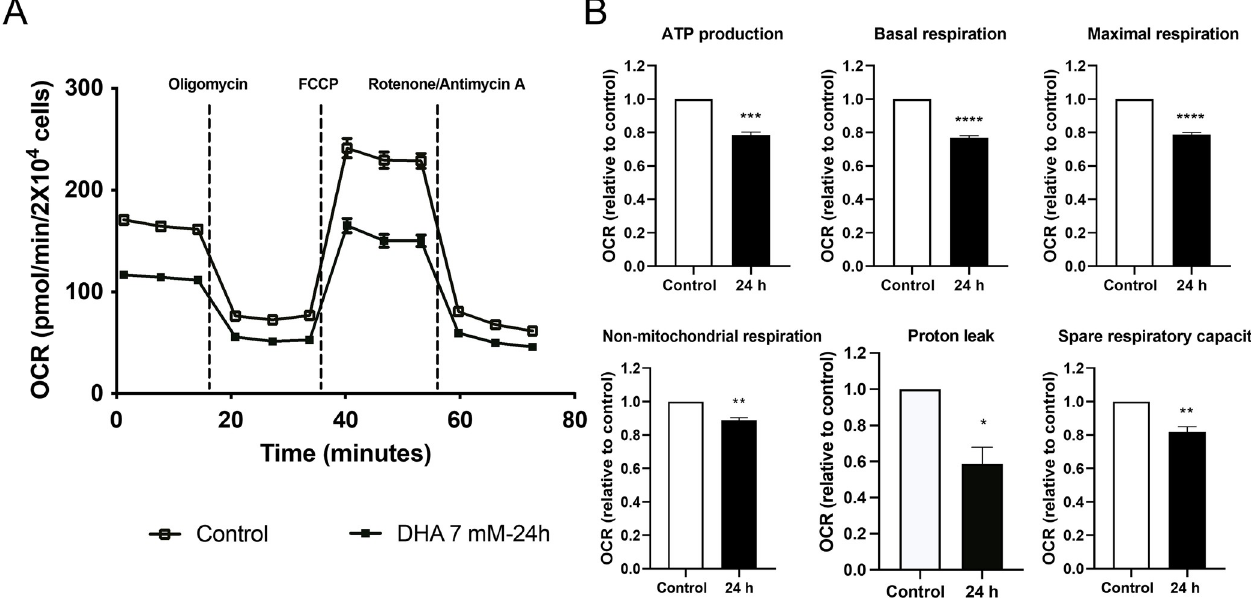
Fig 7. Oxidative phosphorylation is also reduced after 7 mM DHA exposure. (A) Oxygen consumption rate (OCR) decreased at 24 h. (B) All measured parameters showed a significant decrease compared to control cells. The level of statistical significance was marked as follows: � p < 0.05; �� p < 0.01; ��� p < 0.001; ���� p <